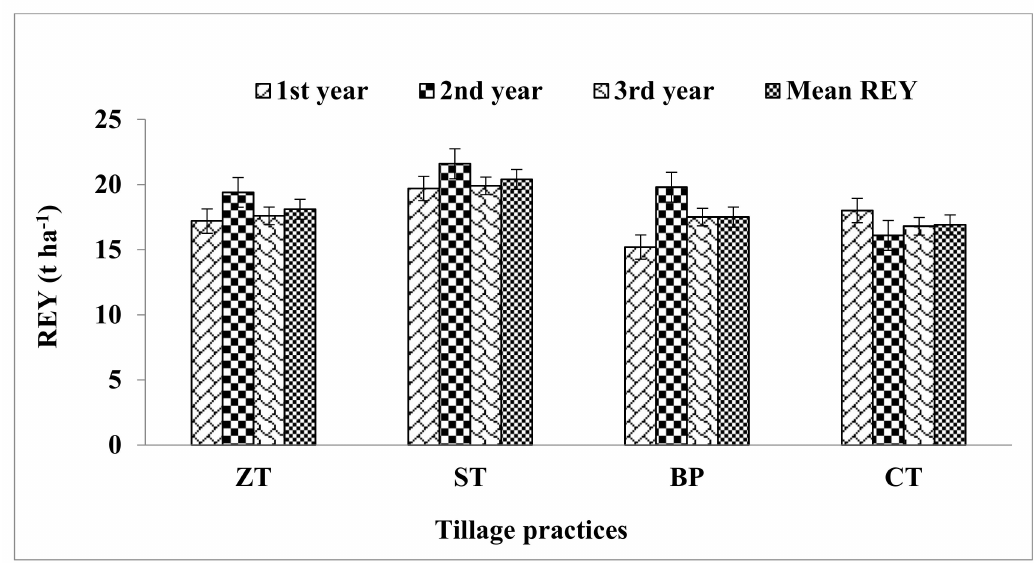
Figure 2. Effect of tillage practices on rice equivalent yield. ZT = zero tillage, ST = strip tillage, BP = bed planting, CT = conventional tillage.